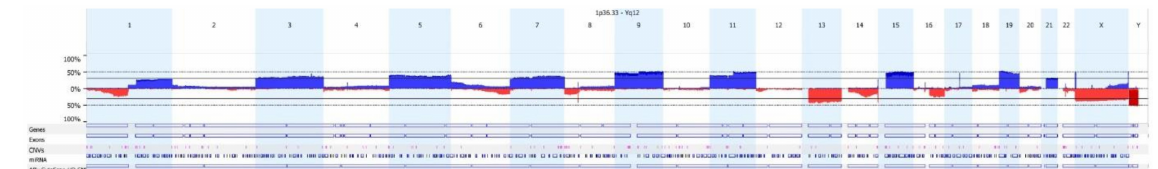
Figure 2. Copy number variation analysis of MM patient samples. Cytoscan HD CNV arrays were performed on CD138- Scheme 97. newly diagnosed MM patients. Copy number variation (CNV) profile was generated for the average change in copy number state across the whole